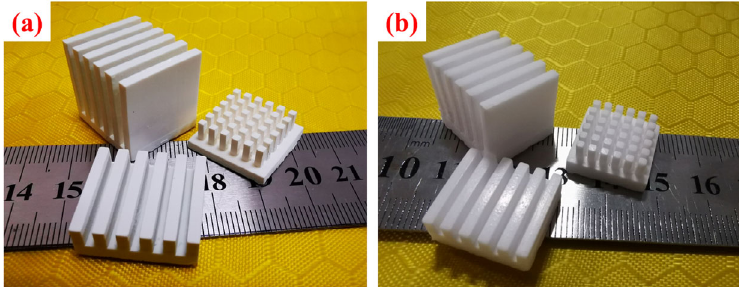
Fig. 14 Optical image of (a) 3D-printed green and (b) sintered fin-type Al 2 O 3 ceramic heat sinks fabricated by a novel approach integrating DLP-stereolithography and CP